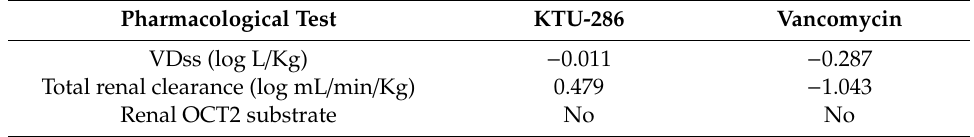
Table 2. The in silico pharmacological excretion characteristics of KTU-286 predicted using pkCSM software.